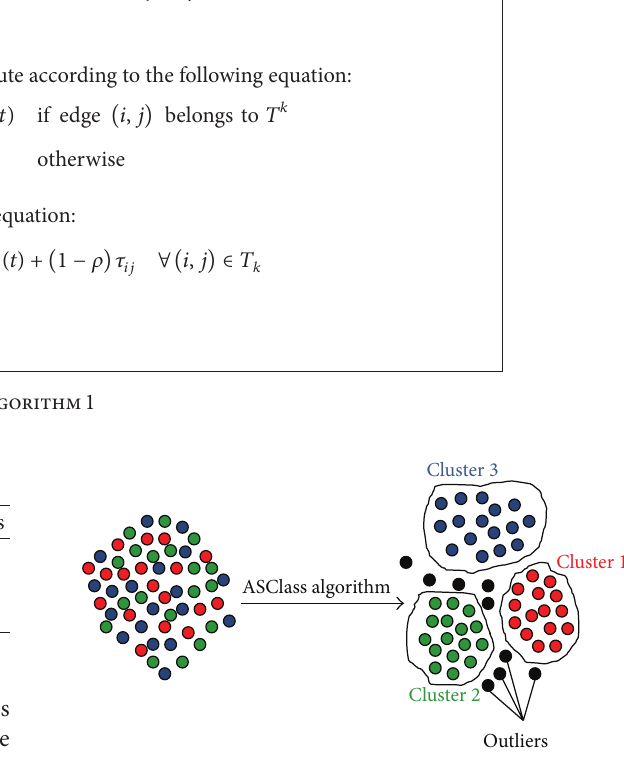
Figure 3: Step 1 of both ASClass i and F-ASClass algorithms.